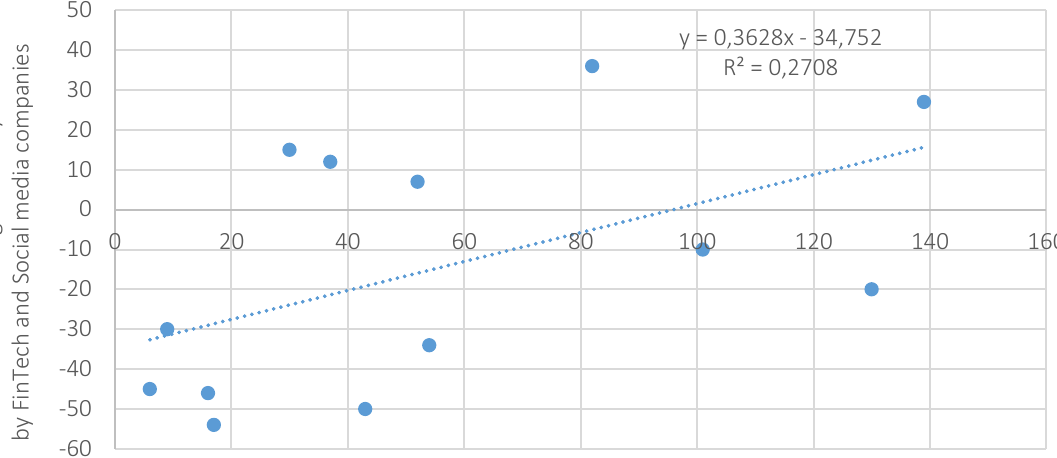
Figure B5. Confidence in privately issued digital money and social